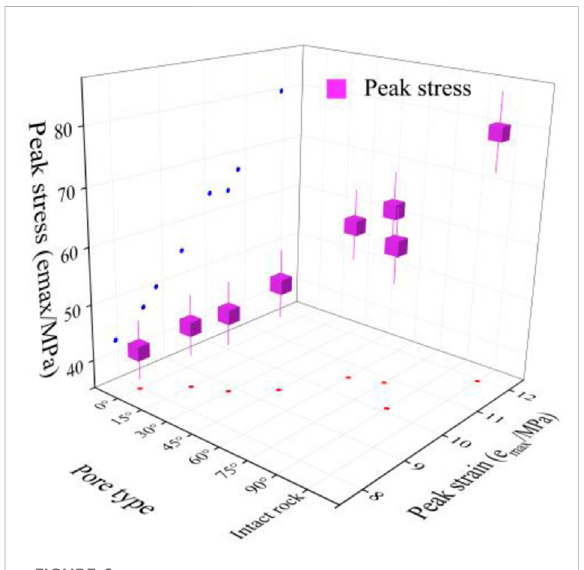
FIGURE 6 Peak stress and peak strain model diagram of the single fracture-hole rock model with different angles of the intact rock and